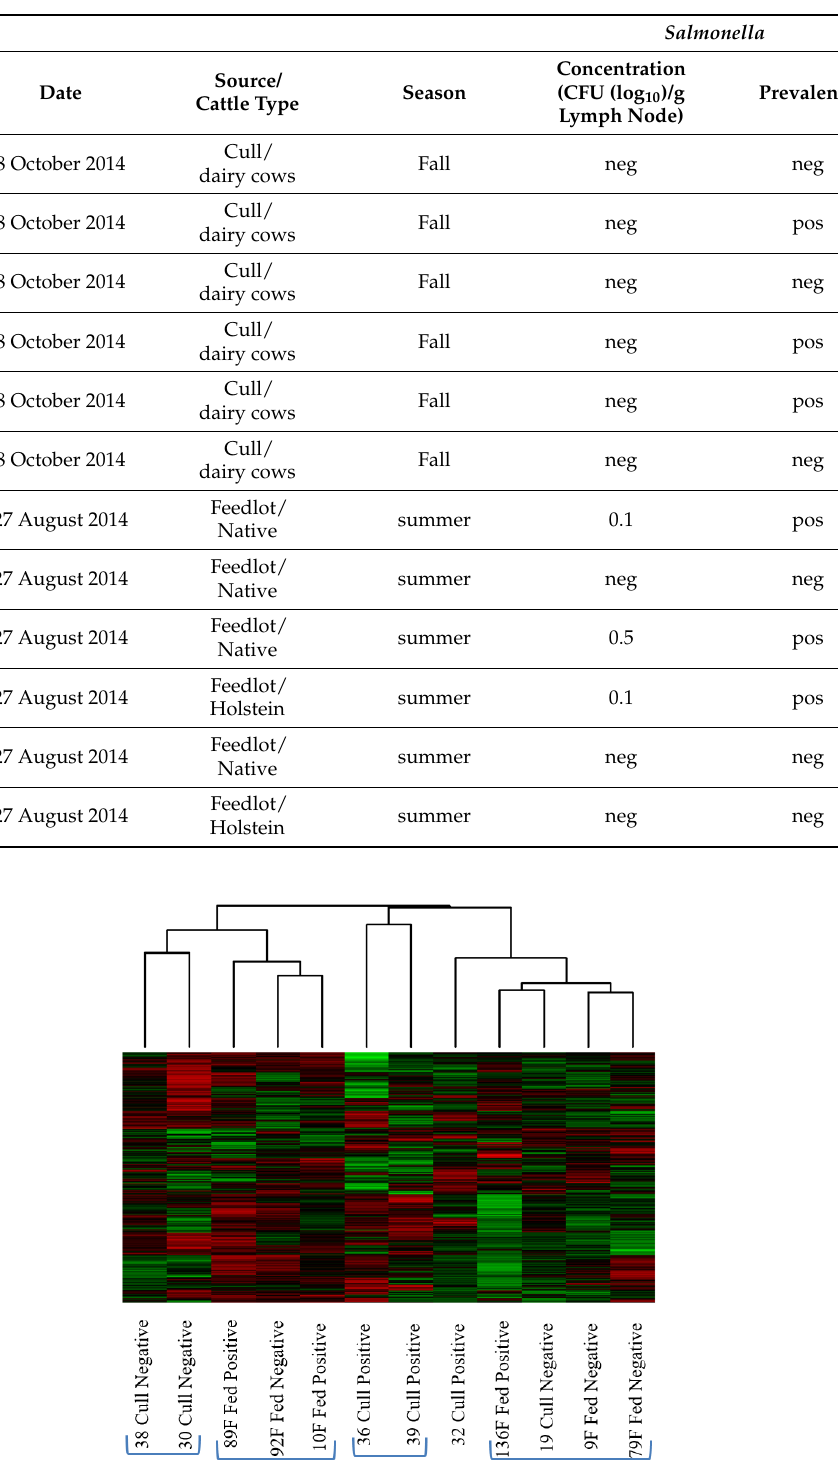
Figure 2. Heatmap and cluster analysis of sub-iliac lymph nodes collected from feedlot (fed) and cull dairy cattle (cull) at slaughter that are either Salmonella positive or negative. Clusters are based on their relative similarity. Each column represents a tissue sample; each row is a peptide. Red represents relative increase in phosphorylation and green relative decrease. Using a different method of data analysis, principal component analysis (PCA) to examine the above data, a clearer cluster pattern was generated. The PCA (Figure 3) shows that clustered around the center of the plot on the PC2 axis, there is a group of Salmonella - negative cattle (between the red lines), both feedlot and cull dairy animals. Only one in- dividual animal that is Salmonella negative lies outside of this center grouping (cull dairy cow #30). Of interest is that in this PCA, the Salmonella -negative animals displayed a sim- ilar pattern while those that were Salmonella positive were broadly scattered across the plot. Table 5 shows the KEGG pathways and Table 6 shows the GO term biological pro- cesses, calculated by comparing feedlot/cull dairy cattle.